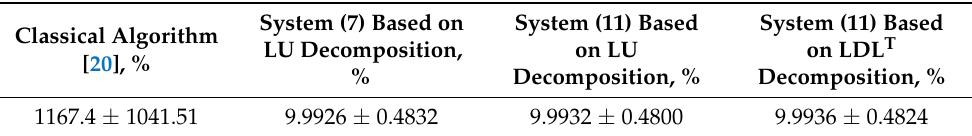
Table 6. The mean values of the normalized root mean square error of parameter estimation and their standard deviations.